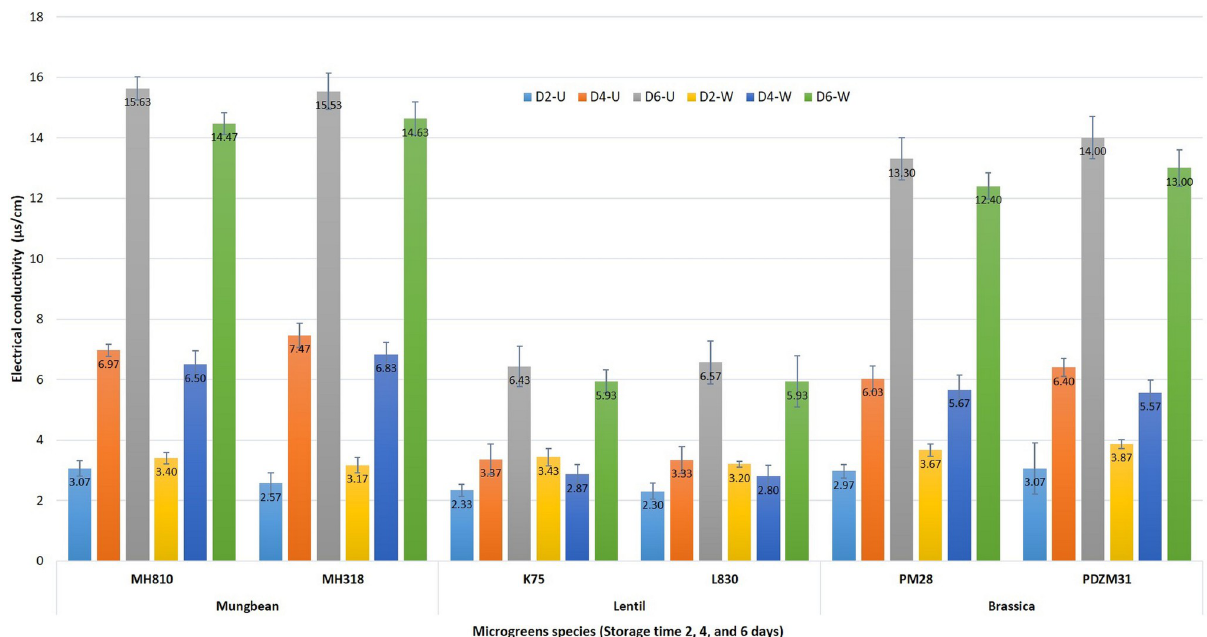
Fig 3. Changes in electrical conductivity of washed (W) and unwashed (U) microgreens samples (mungbean, lentil, and Indian mustard) when packed in LLDPE films during the 2 nd , 4 th , and 6 th day of storage at 4˚C. Where D2-U, D4-U, and D6-U are ‘unwashed’; while D2-W, D4-W, and D6-W are ‘washed’ microgreens samples at 2 nd , 4 th , and 6 th day of storage, respectively. Values are expressed as mean ± SD (n = 3) and different letters indicate a significant difference ( P �